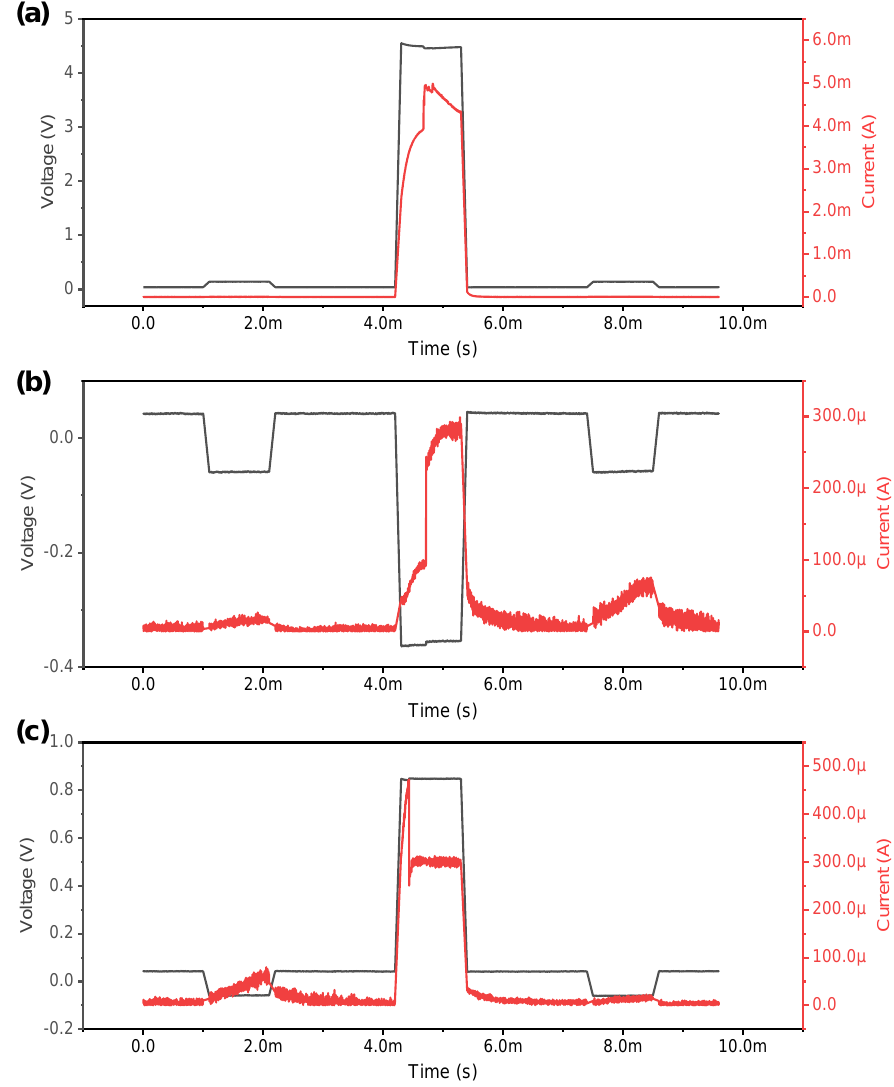
Figure 4. Pulse transient characteristics for ( a ) volatile switching. ( b ) Set process and ( c ) reset process for memory resistive switching.